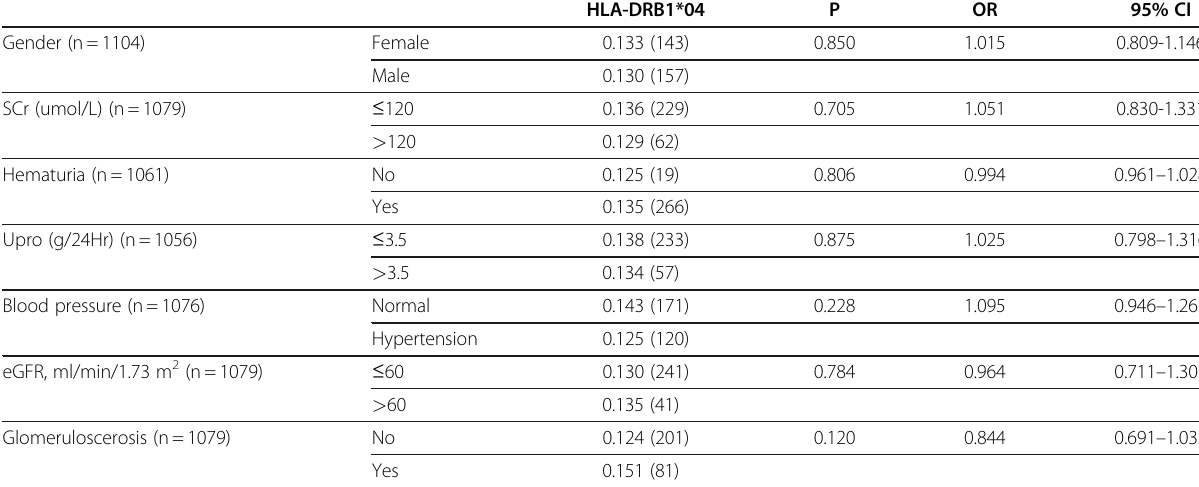
Table 5 The association of HLA-DRB1*04 alleles with clinical and pathological parameters of primary IgAN